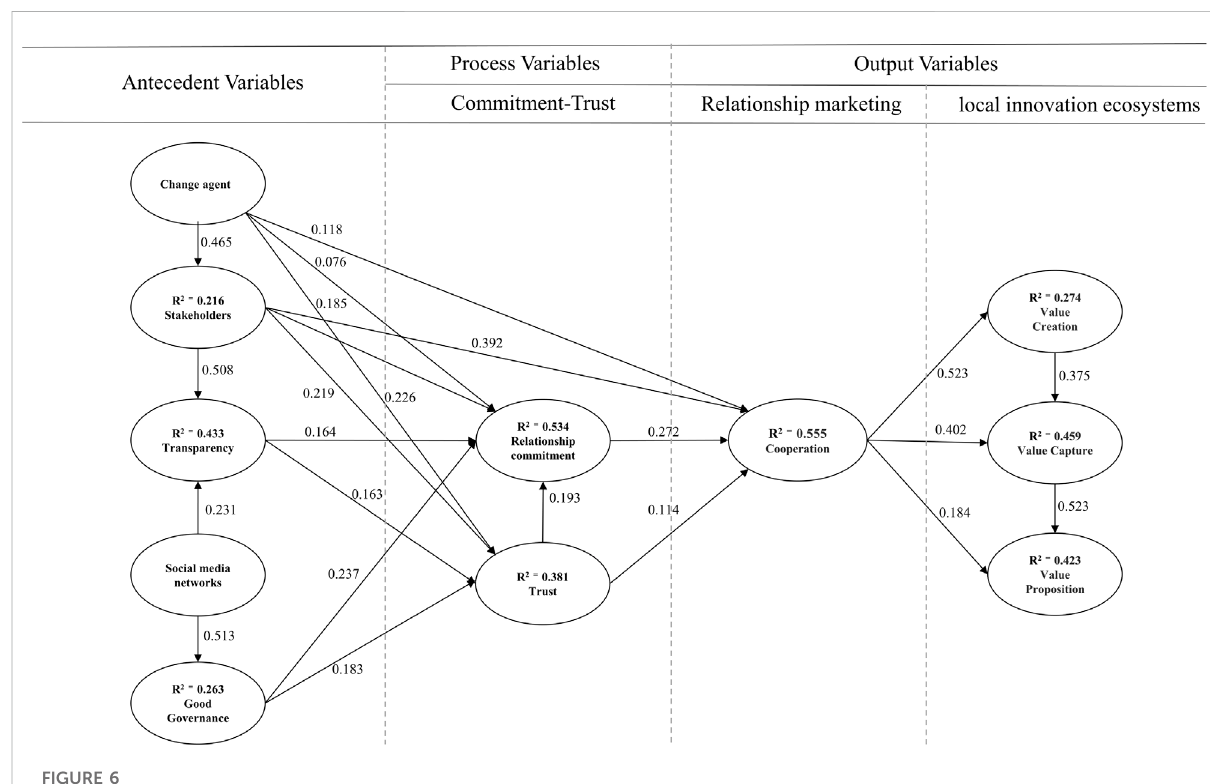
FIGURE 6 PLS algorithm